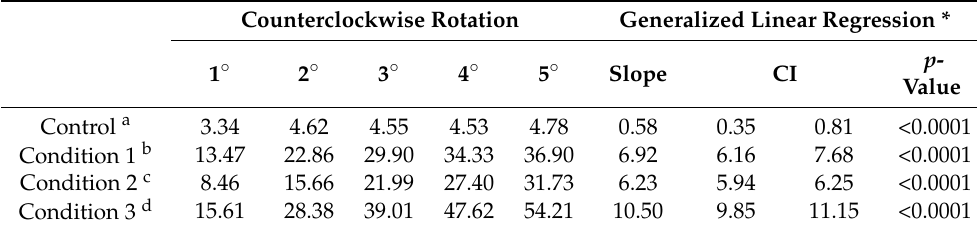
Table 3. Overall moment (Nmm) required to unwind the miniscrew in each degree of counterclock- wise rotation.